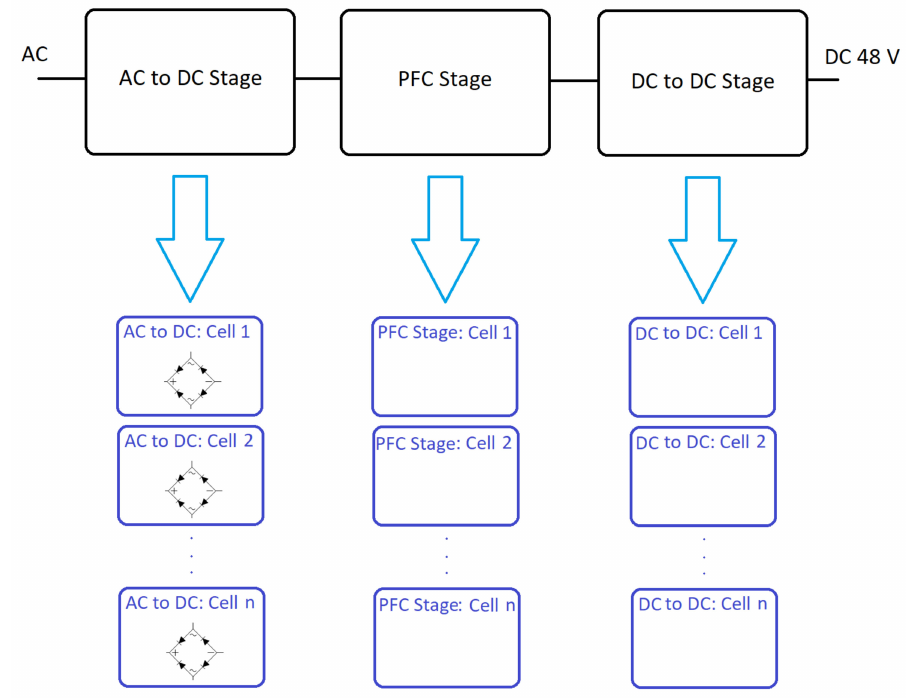
Figure 3. Block diagram of a multicell